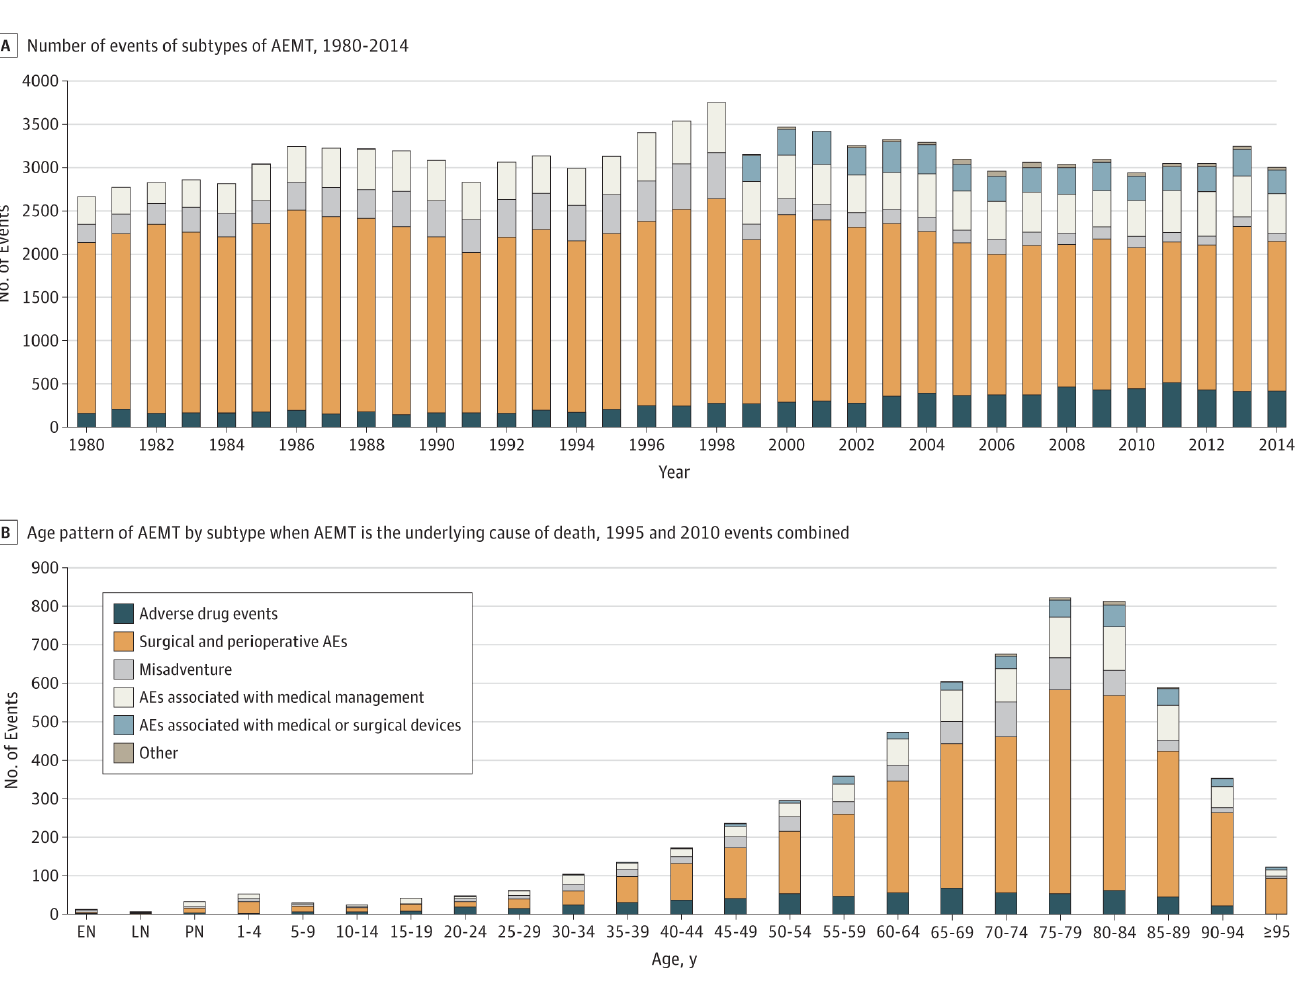
Figure 5. The changes on the number of medical errors over time and for different ages [59]. Abbreviations used: AEMT, Adverse Effects of Medical Treatment; and AE, Adverse Effects.